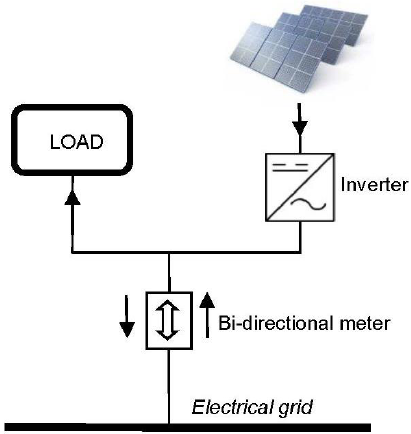
Figure 3. Grid-connected PV-only system under net-metering policy.